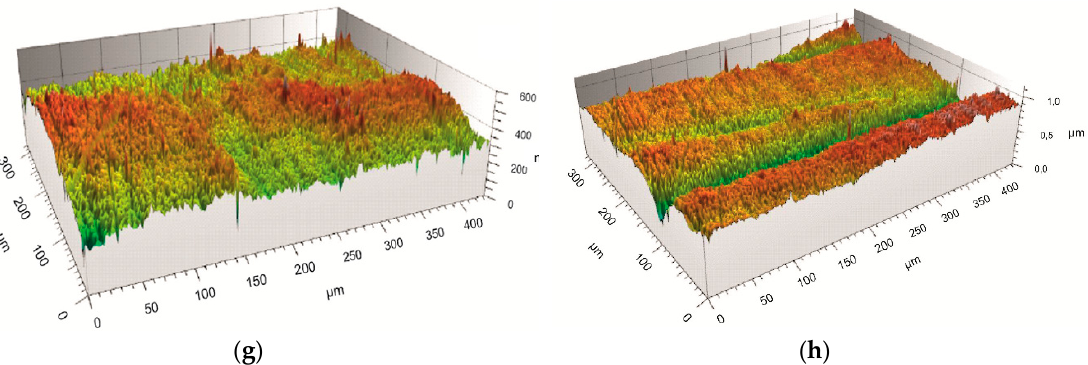
Figure 4. Topography of flat surfaces of specimens from alloys D16ChATW ( a , c ) and 2024-T351 ( e , g ) in the initial state ( a , c , e , g ) and after DNP ( b , d , f , h ): ( a , b , e , f )–two-dimensional (2D)-measurements; ( c , d , g , h )–three-dimensional (3D)-measurements.